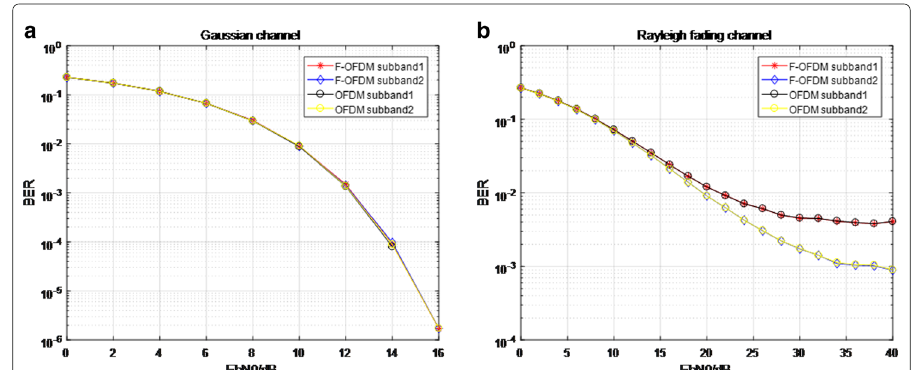
Fig. 8 BER comparison of OFDM and F-OFDM